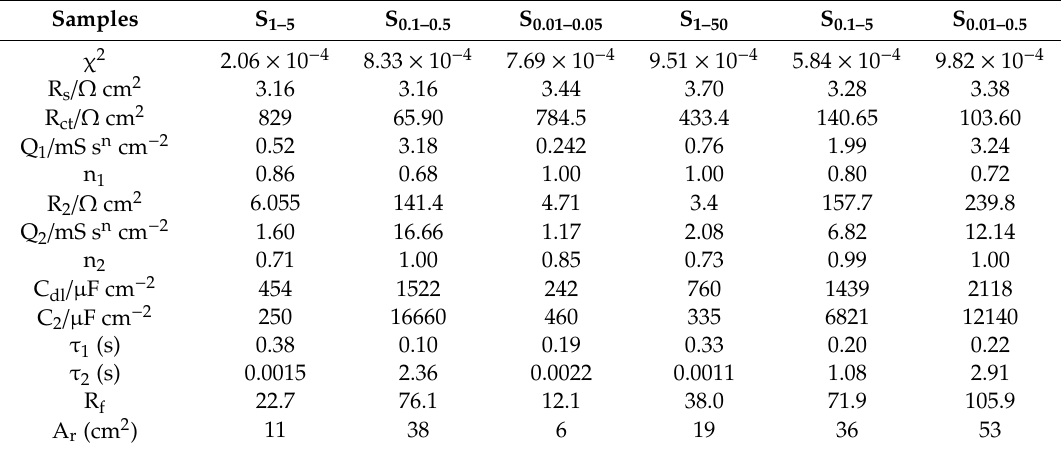
Table 2. Electrical circuital parameters obtained from the fit of EIS spectra at open circuit potential for the synthesized samples, recorded in KOH 1